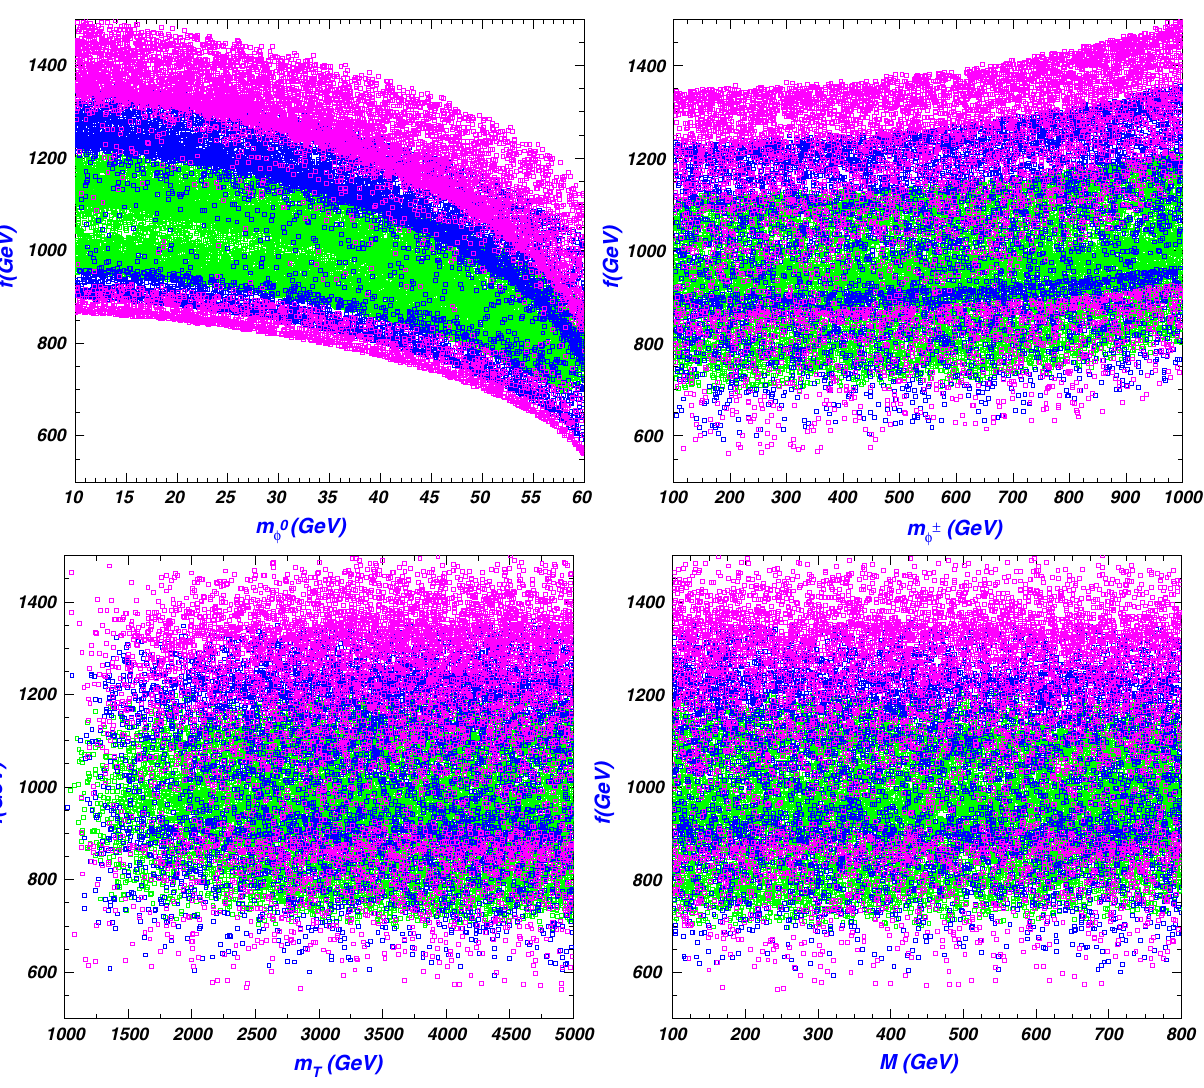
on the planes of f versus m φ 0 , m φ ± , m T , and M . The green, blue and the pink h